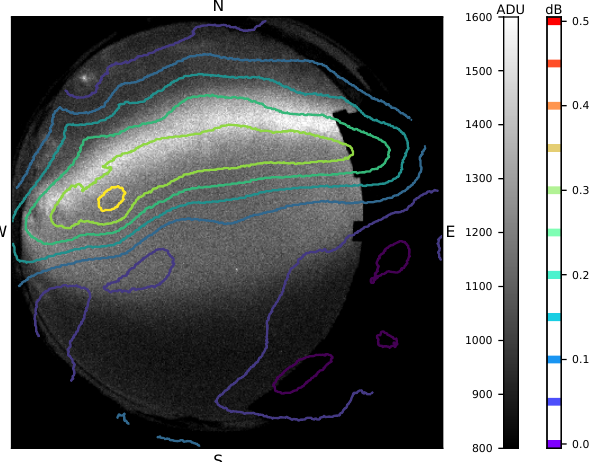
Figure 3. Optical summary keogram with overlaid riometric con-